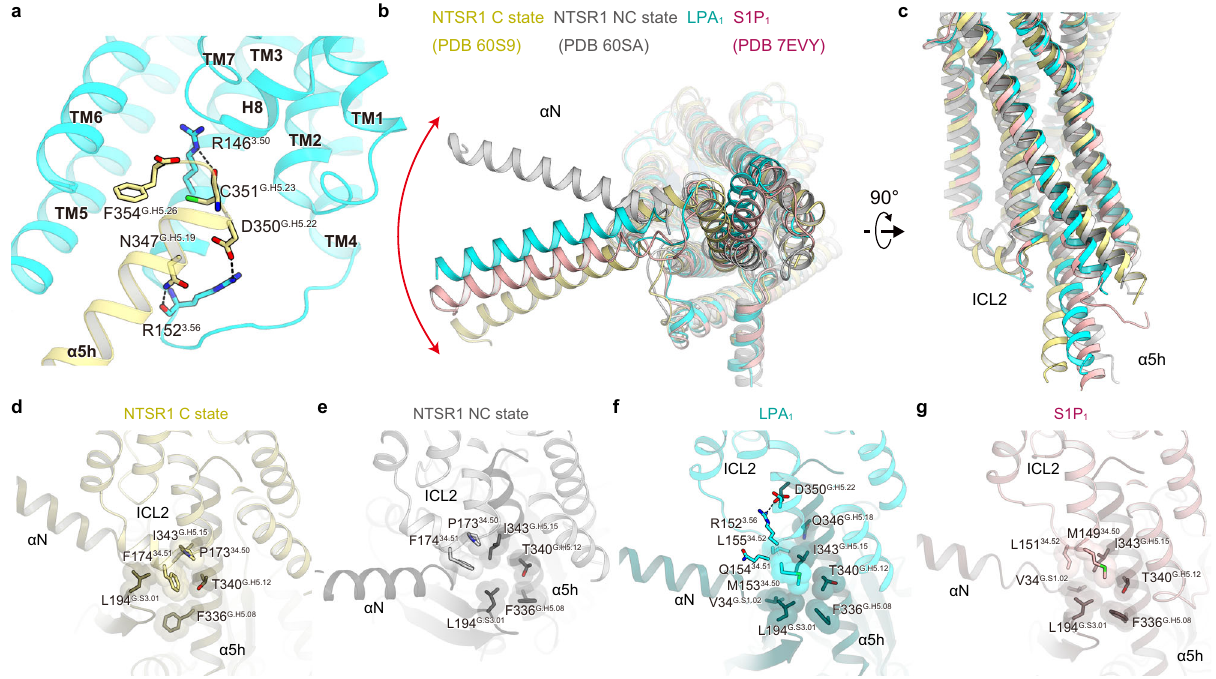
Fig. 5 | Binding modes of G i . a Main hydrogen-bonding interactions between the receptor and the α 5 helix of G α i1 . b , c Structural comparisons of LPA 1 -G i with other GPCR-G-protein complexes at the interface, viewed from the cytoplasmic side ( b )